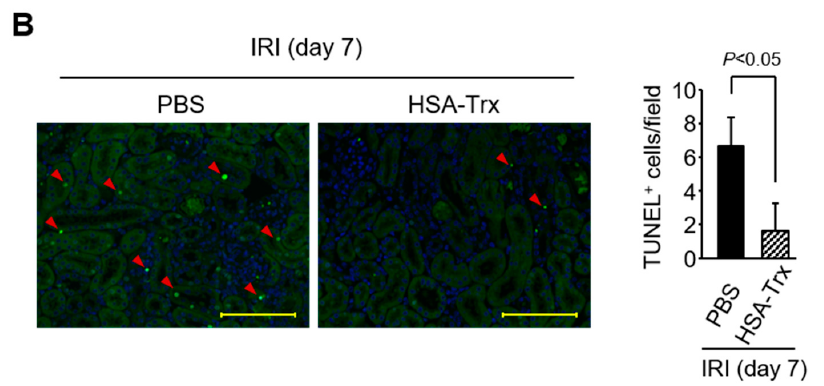
Figure 4. Effect of HSA-Trx on the G2/M arrest of renal tubular cells and tubular apoptosis in renal IR-treated mice at 7 days after renal IR. ( A ) Representative photomicrographs and quantification of the immunostaining of renal Ki67 (green) and PH3 (Phospho-Histone H3, red) are shown 7 days after renal IR. Cells were also treated with DAPI (blue). Serial sections of kidney were used in Ki67 and PH3 immunostaining. Ki67 or PH3-positive cells are indicated by arrowheads. Lower panels are enlarged images of the upper and middle panel. Original magnifications: ×100. Scale bars represent 100 µ m. * p < 0.05 compared with sham mice. ( B ) Effect of HSA-Trx on renal tubular cell apoptosis in renal IR-treated mice during 7 days after renal IR: Representative photomicrographs and quantification of TUNEL-stained kidney sections are shown. TUNEL -positive cells are indicated by arrowheads. Cells were also treated with DAPI (blue). Original magnifications: ×400. Scale bars represent 100 µ m.